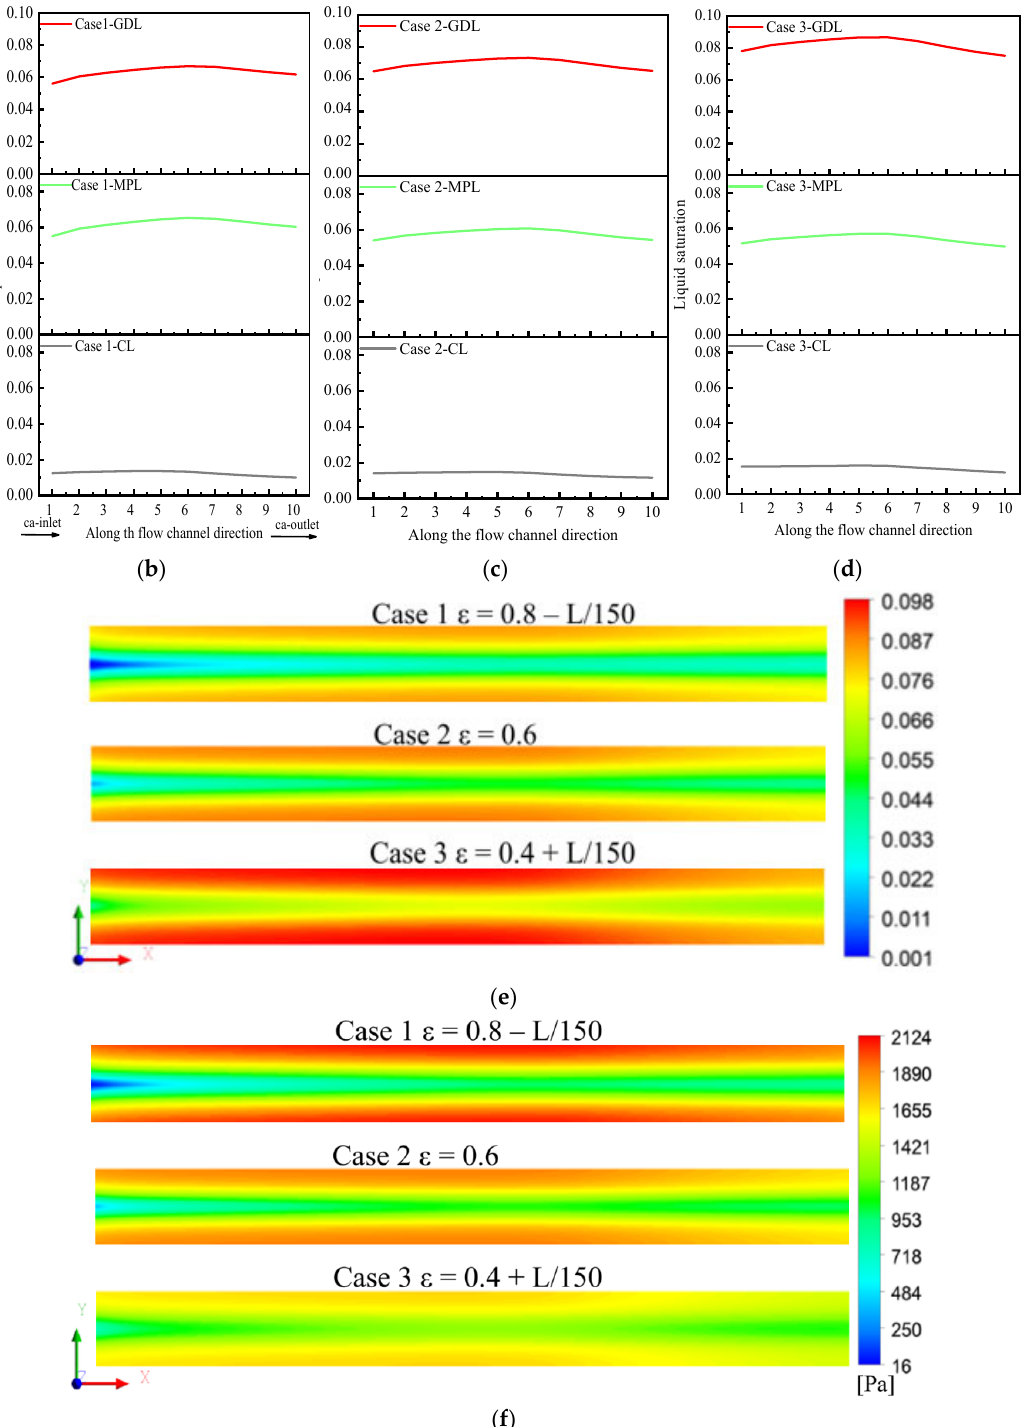
Figure 8. ( a ) Distribution of the liquid saturation in MEA of Case 1, ( b – d ) comparison of the liquid water distribution in cathode GDM for the three cases, ( e ) distribution of liquid saturation at the 1/2 thickness of the GDLs, ( f ) distribution of the capillary pressure at the 1/2 thickness of GDLs.